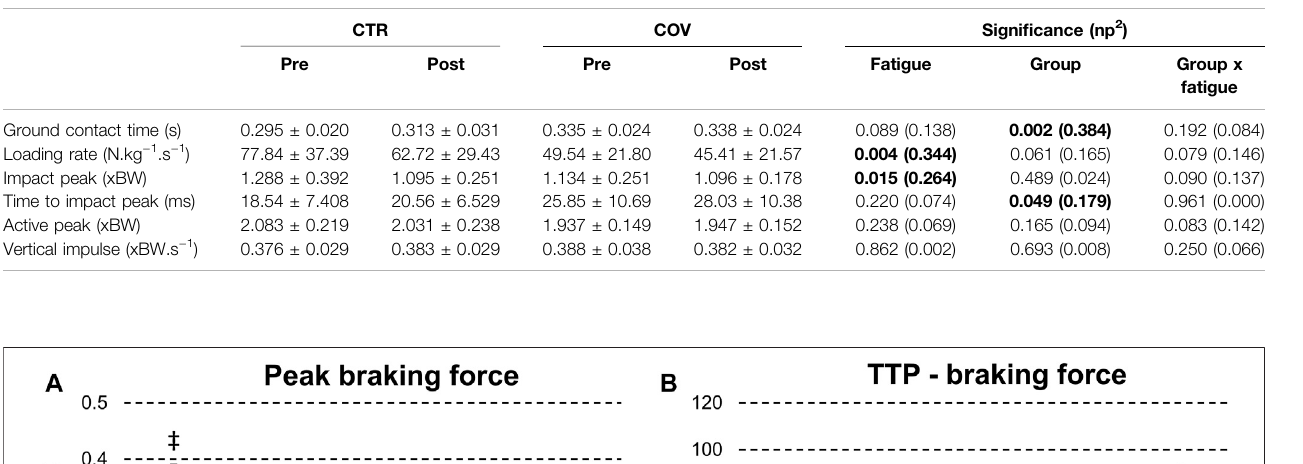
TABLE2| MeansandstandarddeviationsforgroundreactionforceparametersextractedfromthecontrolandtheCOVID-19groupbefore(Pre)andafterfatigue(Post).The signi fi cance level (p) and effect size (partial eta-squared, np 2 ) illustrate main effects of fatigue, group and the fatigue-by-group interactions. Signi fi cant effects are expressed in bold.